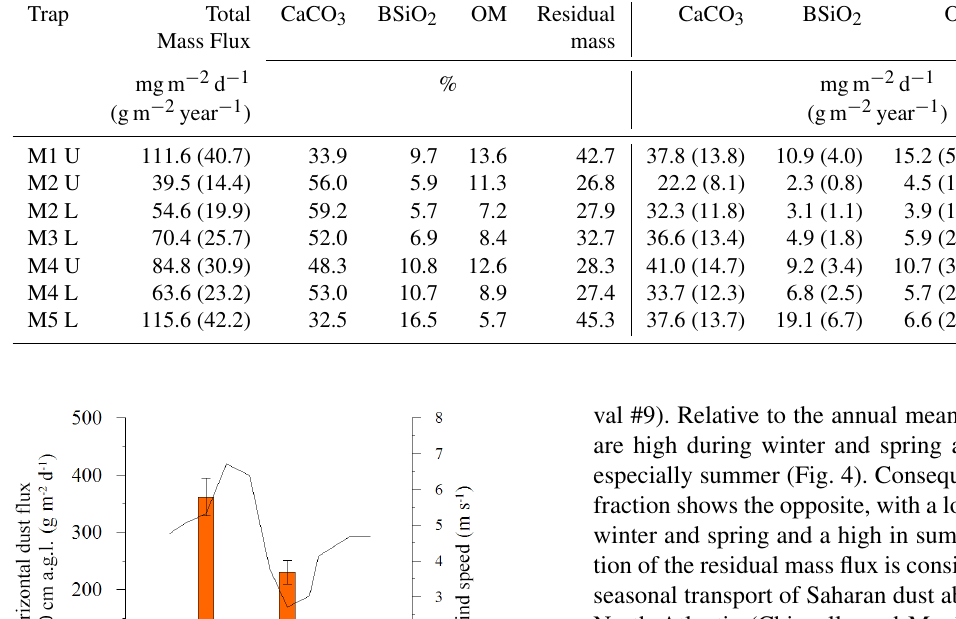
fraction shows the opposite, with a low relative abundance